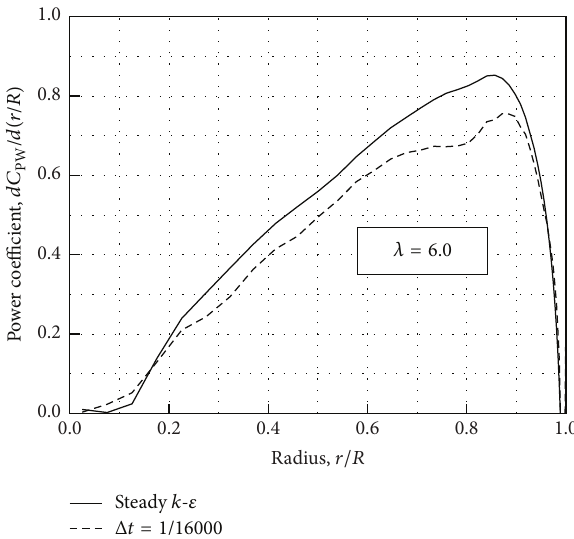
Figure 8: Local power coefficient for tip speed ratio 𝜆 = 6